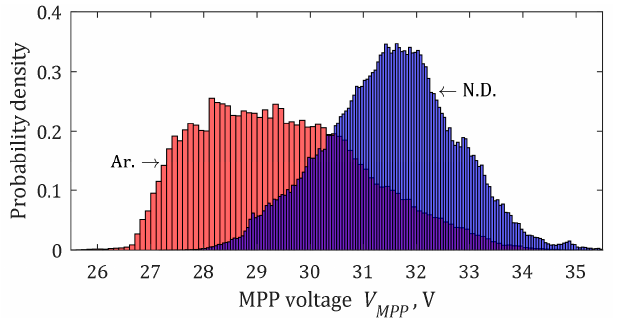
Figure 13. Density distribution of the MPP voltages.